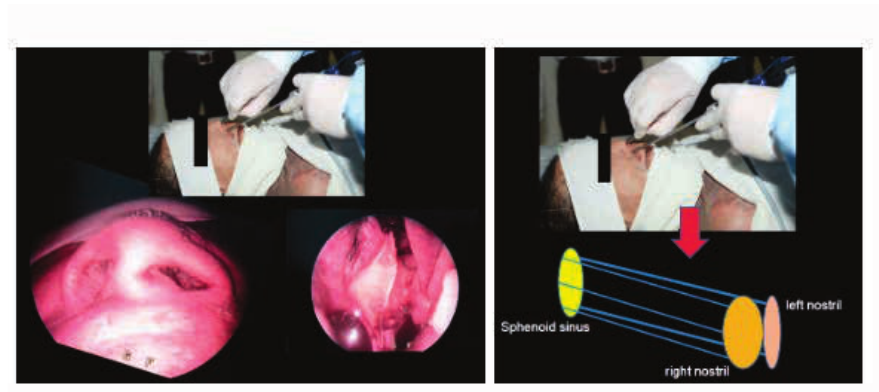
Figure 6: Cylindrical diagrams relevant to the EET approach showing the significant reference